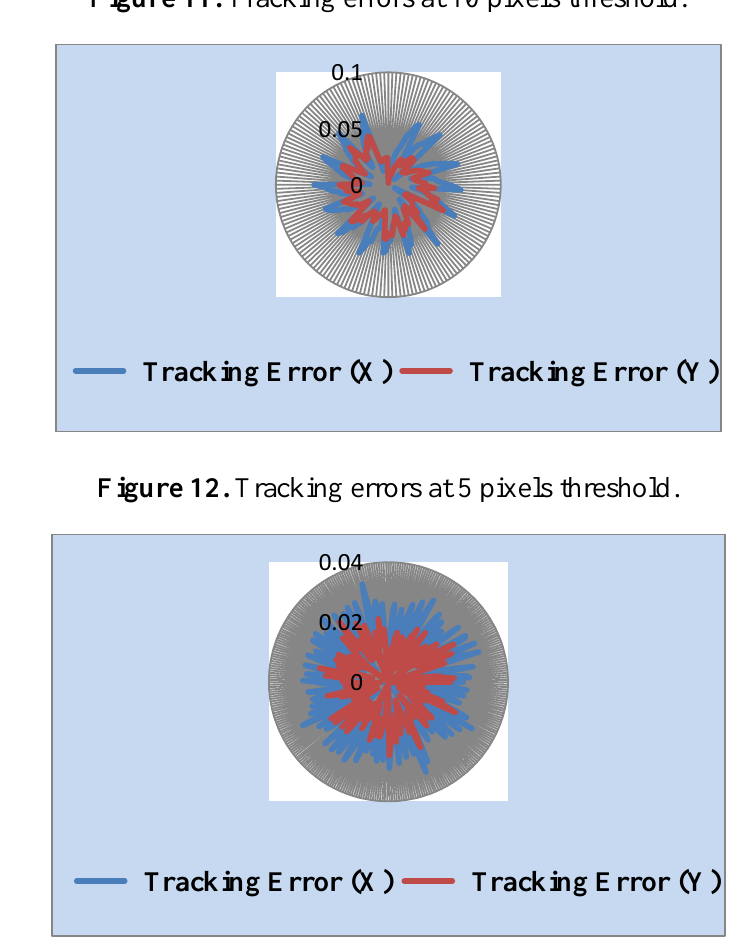
Figure 11. Tracking errors at 10 pixels threshold.